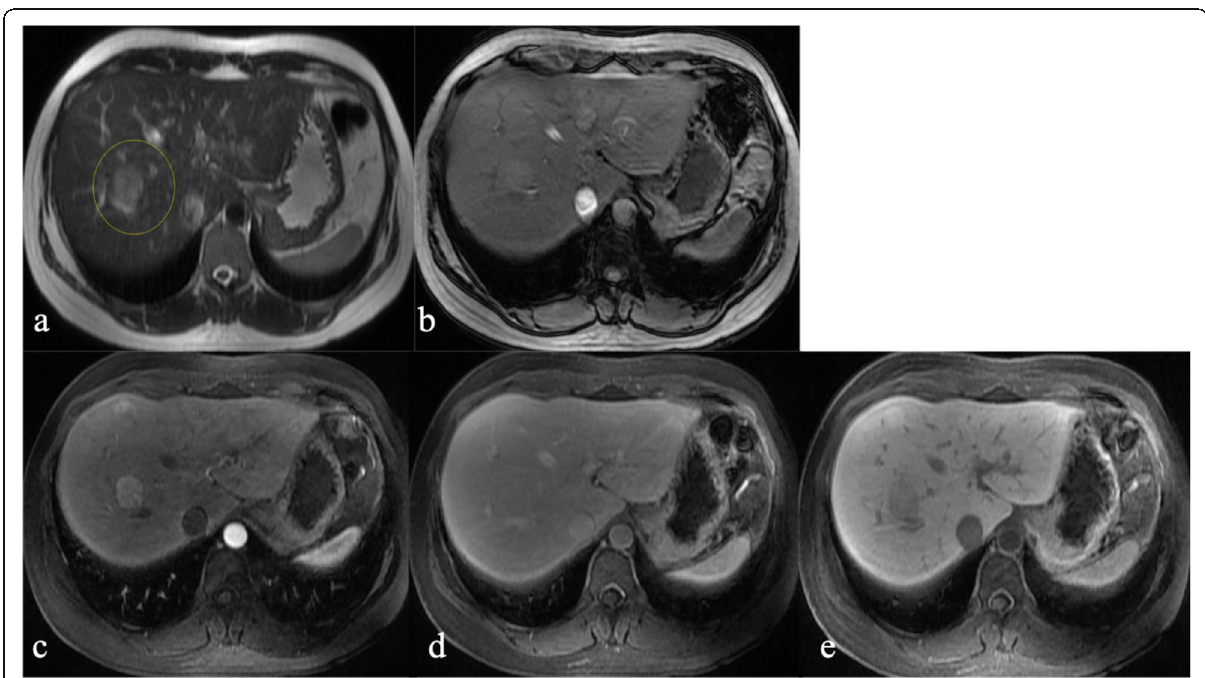
Fig 2. 31-year-old female with pathologically proven FNH. Axial T2W ( a ) and axial T1W opposed-phase ( b ) prior to surgery demonstrate a heterogeneous mildly T2 hyperintense lesion in segment III (yellow dotted circles in a ) with no internal fat. Gd-EOB-DTPA-enhanced axial T1W fat-saturated sequences demonstrate heterogeneous arterial enhancement ( c ), iso-intense signal in the portal-venous phase ( d ), and retention of contrast in the HPB phase ( e ). R1 initially classified this lesion as adenoma but correctly reclassified as FNH after assessment of the HPB phase. R2 correctly classified this lesion as FNH before and after assessment of the HPB phase. Confidence in diagnosis increased from moderate to high certainty for R2 and remained at high certainty for